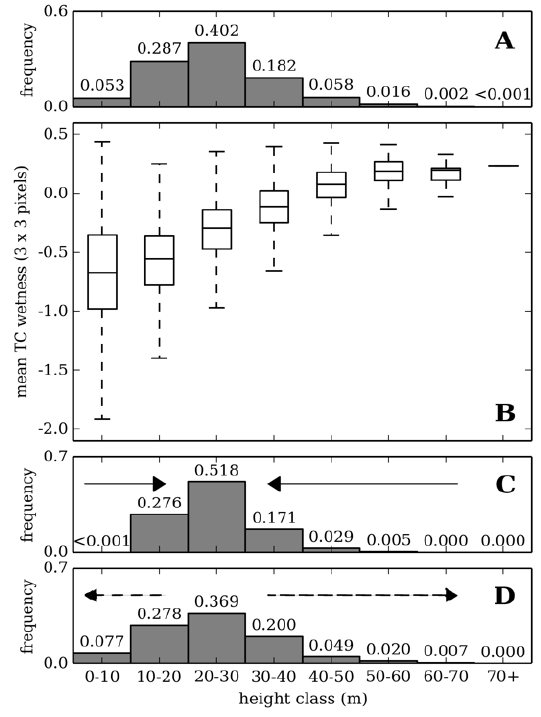
Figure 4. A comparison of the response variable distribution ( A ), range of Tasselled Cap wetness values (3 × 3 pixels) ( B ) and the distributions of modeled canopy height (random forest ( C ) and random forest-systematic error ( D )) for different height classes. The solid arrows indicate the direction in which the random forest model output was “squeezed” by inequity in response variable distribution; the dashed arrow indicates the direction canopy height values were rescaled after correcting for systematic